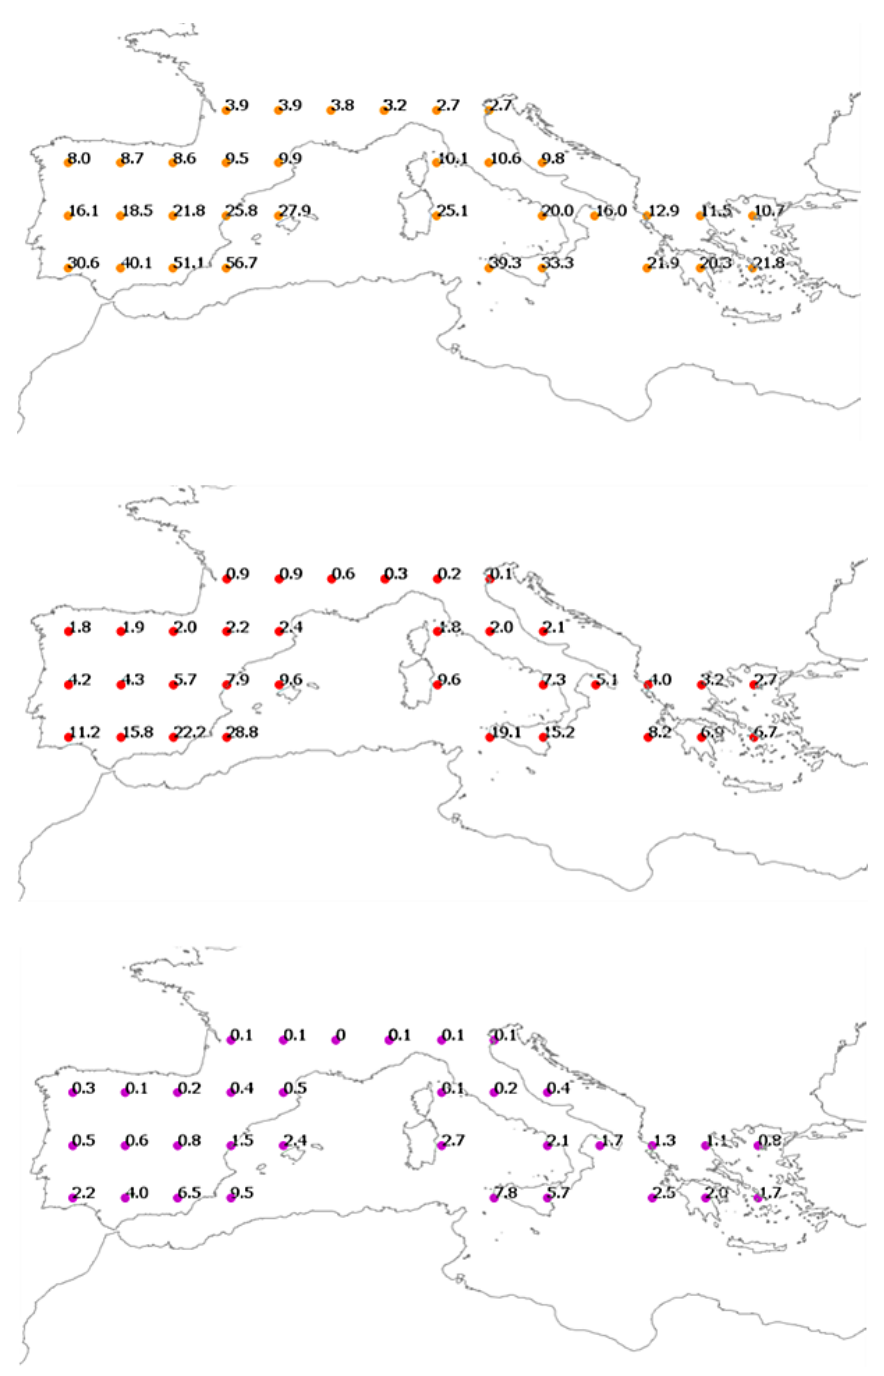
Figure 2. Mean annual number of days with an air temperature higher than 20 ◦ C (orange points), 22.5 ◦ C (red points), and 25 ◦ C (purple points) at 850hPa in the June–September period from 1978 to